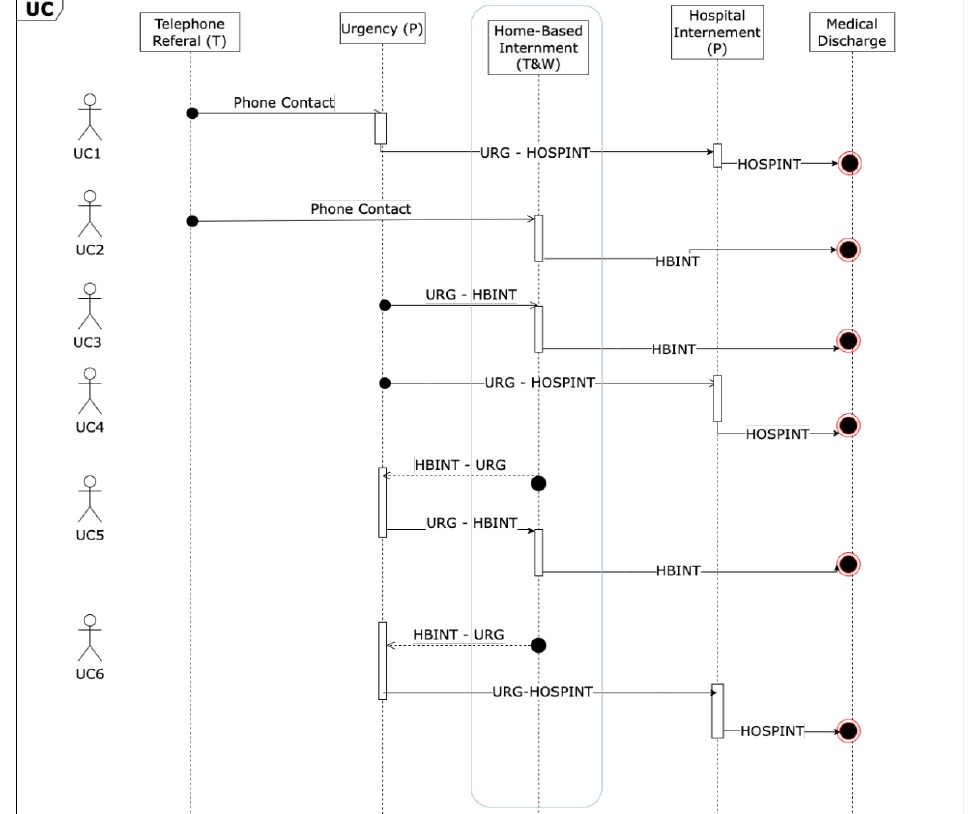
Figure 3. COVID-19